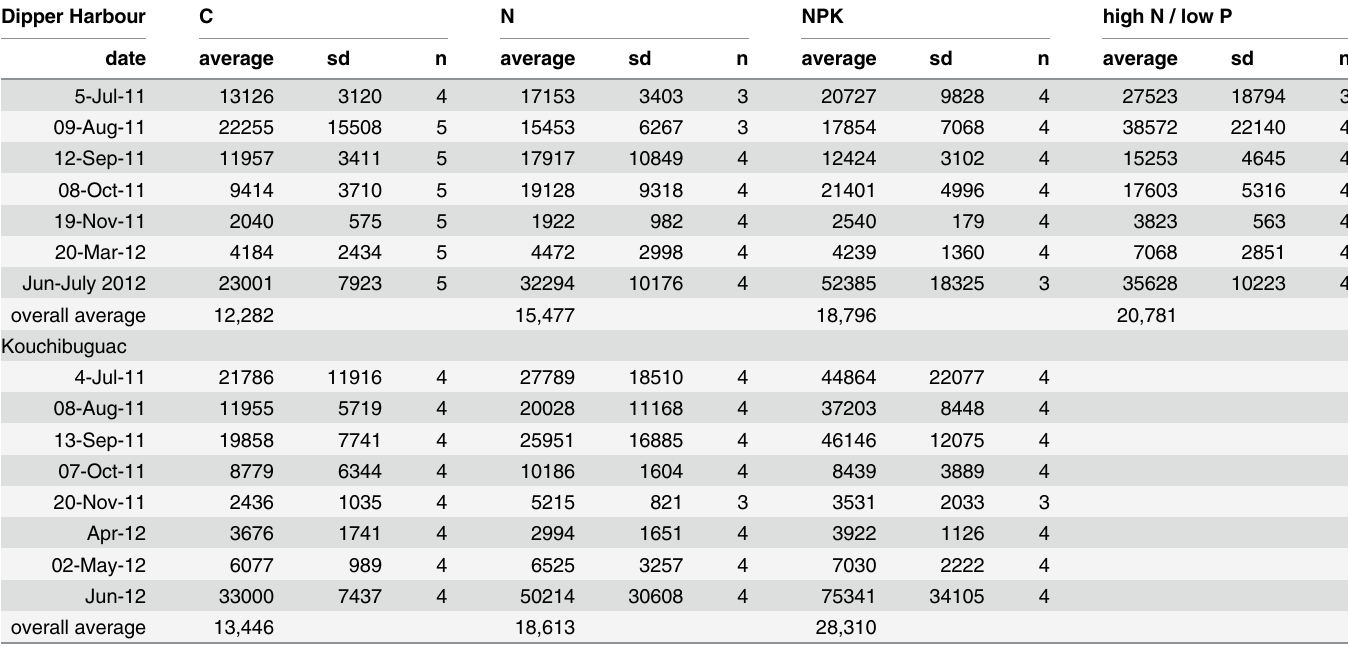
Table 3. Average CO 2 fluxes by sample event in μ moles m -2 hr -1 .